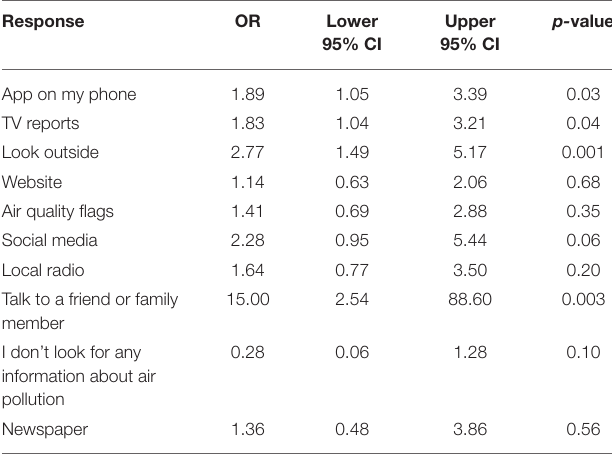
TABLE 2 | Odds ratio (OR) of preferred sources for air pollution information as reported by participants with COPD vs. asthma.